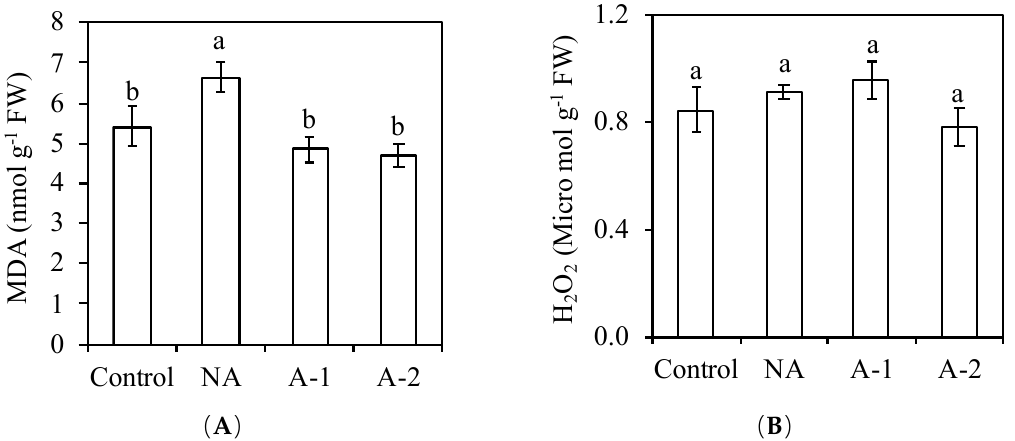
Figure 6. Effects of 10-days sodic-alkalinity with 100 mM NaHCO 3 on malondialdehyde (MDA) ( A ) and hydrogen peroxide (H 2 O 2 ) ( B ) of pre-acclimated rye. Rye plants were pre-acclimated by 0 mM NaHCO 3 (NA) and 1 and 2 mM NaHCO 3 (A-1, A-2) for 10 days. Control plants were consistently irrigated by nutrient solution. Significance testing was performed using ANOVA analysis followed by Duncan’s multiple range test at p ≤ 0.05. The values are means ( ± SE) of five replicates. Means followed by the same letter are not significantly different.